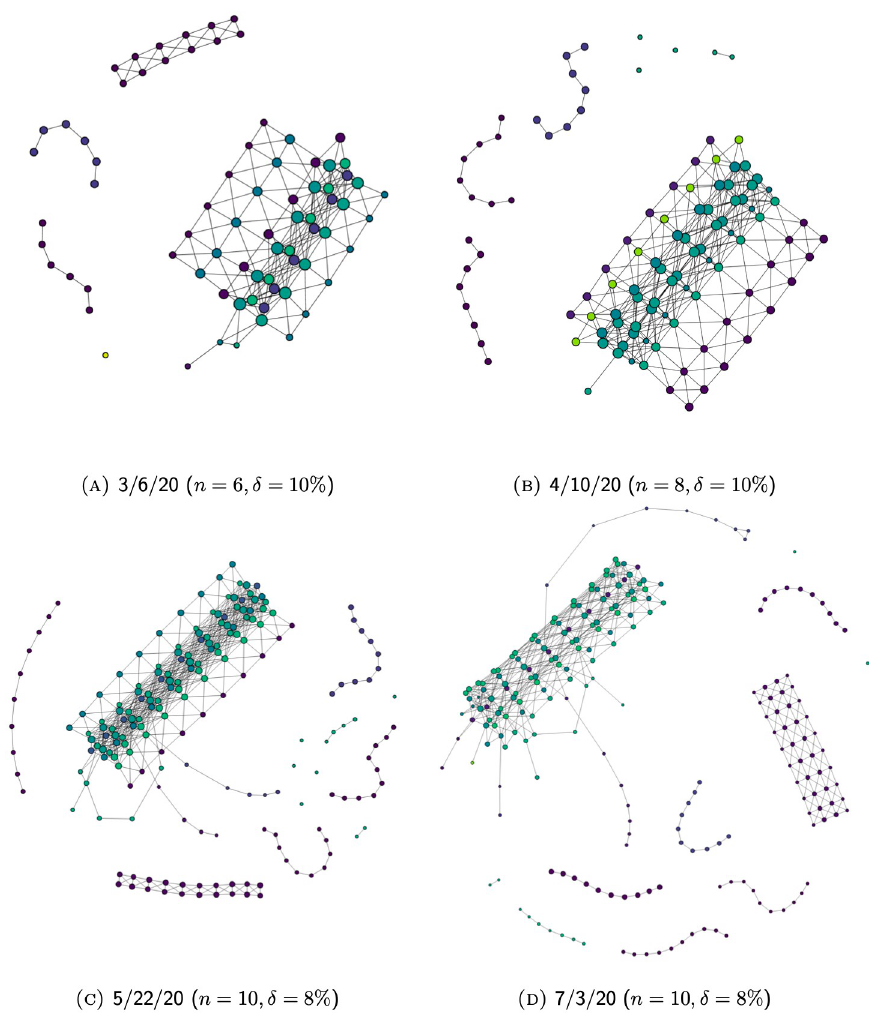
Fig 11. The evolution of Mapper graphs over time for unfiltered